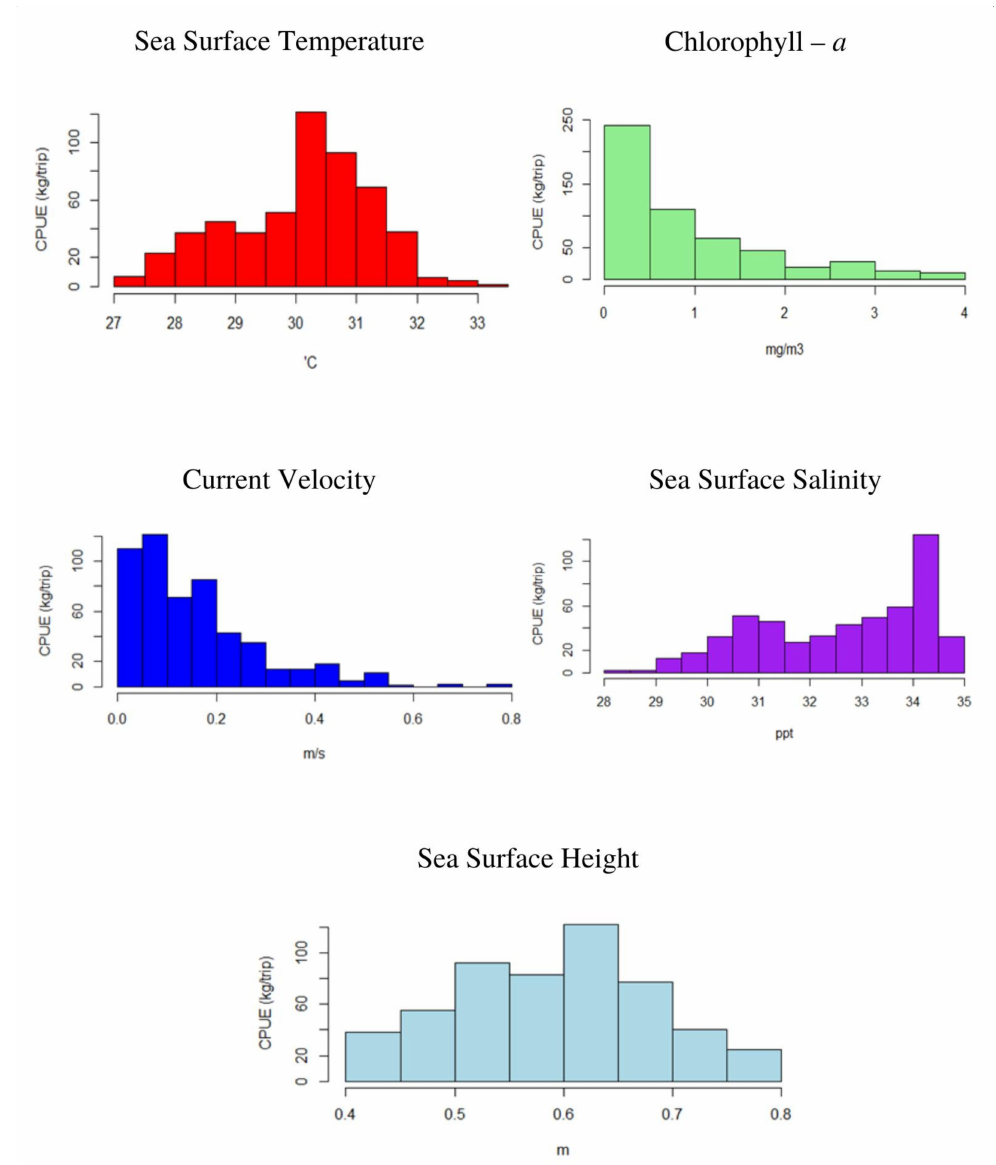
Figure 8. Histogram showing the frequency of CPUE and oceanographic parameters. Here, the fish